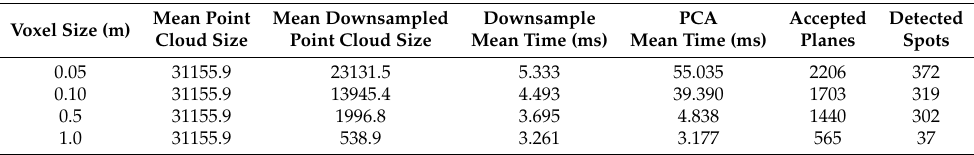
Table 7. Results for several values of voxel size in the